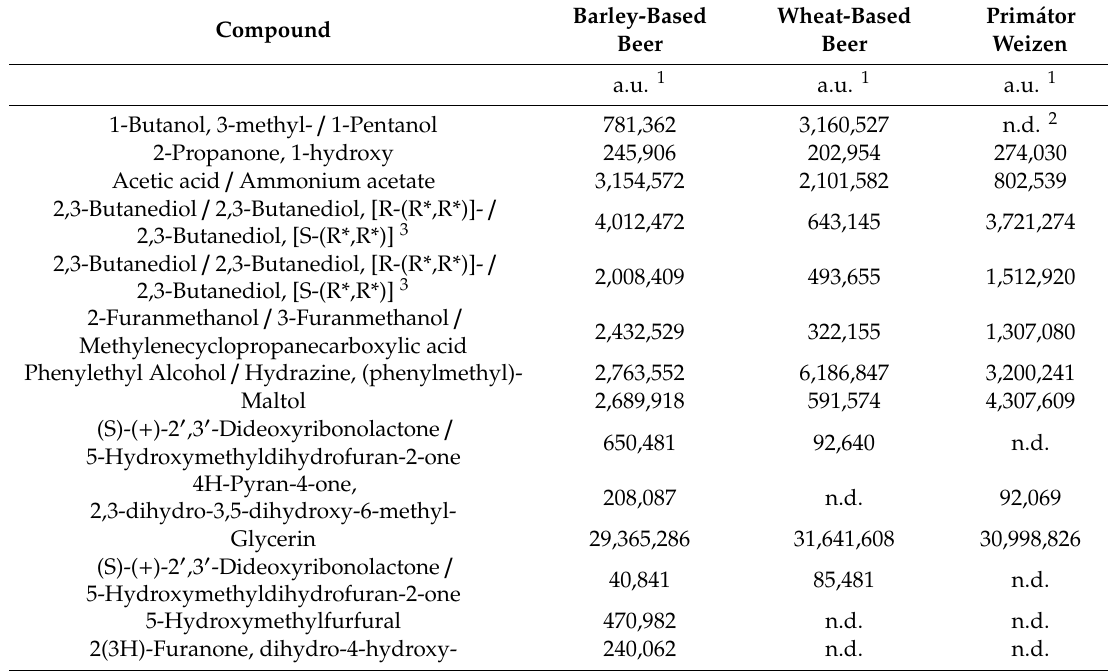
Table 2. Results of GC-MS analysis of main products (beers). Values of peaks excluding water and ethanol. All compounds with match factor ≥ 90%, detected by NIST-14 MS library, presented and separated using “ / ”. Order accordingly to respective match factors.